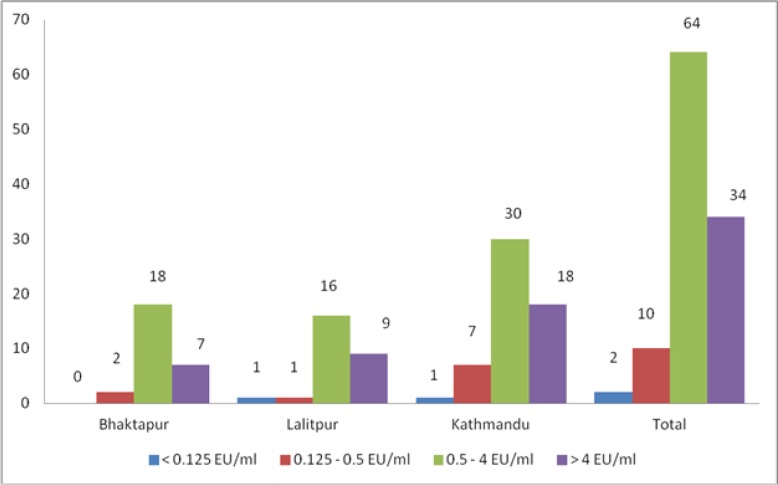
Sampling sites and sampling locations in three selected districts of Kathmandu Valley.